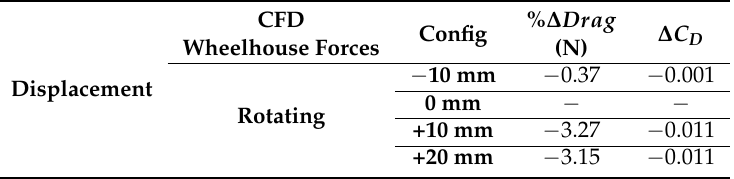
Table 6. Computational wheelhouse forces: wheel